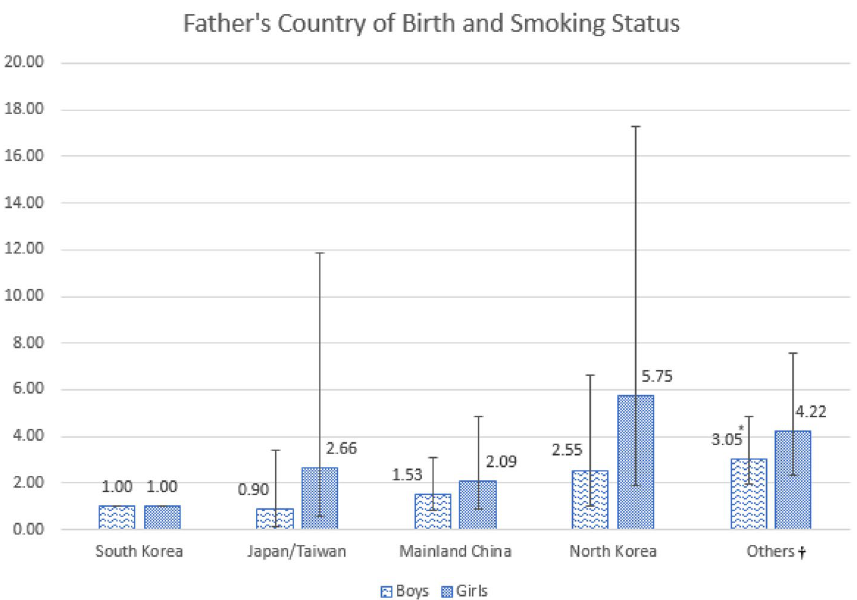
Figure 1. Subgroup analysis of the association between Fathers’ Country of Birth and Smoking Status. *P < 0.05, **P < 0.01, *** P < 0.001. † Countries including Vietnam, Philippines, Mongolia, Thailand, Cambodia, Russia and